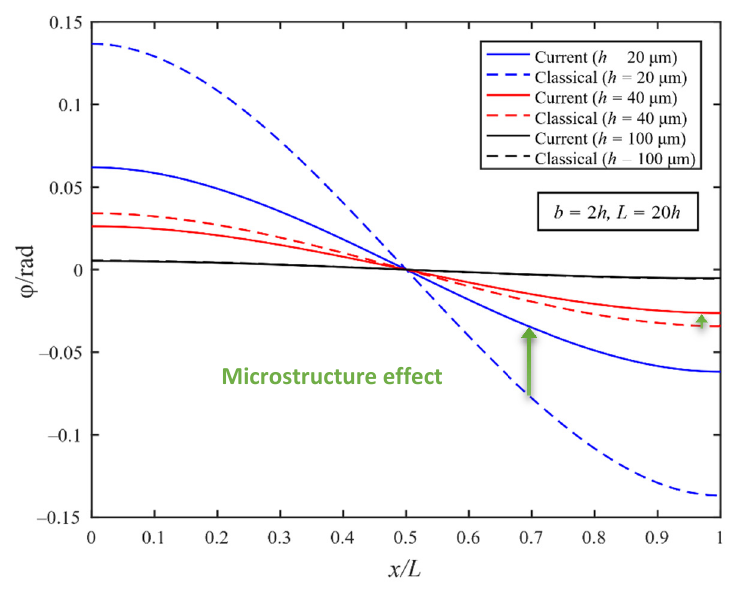
Figure 5. Rotation of the MEE-FGM simply supported beam (Gradient index n = 5).